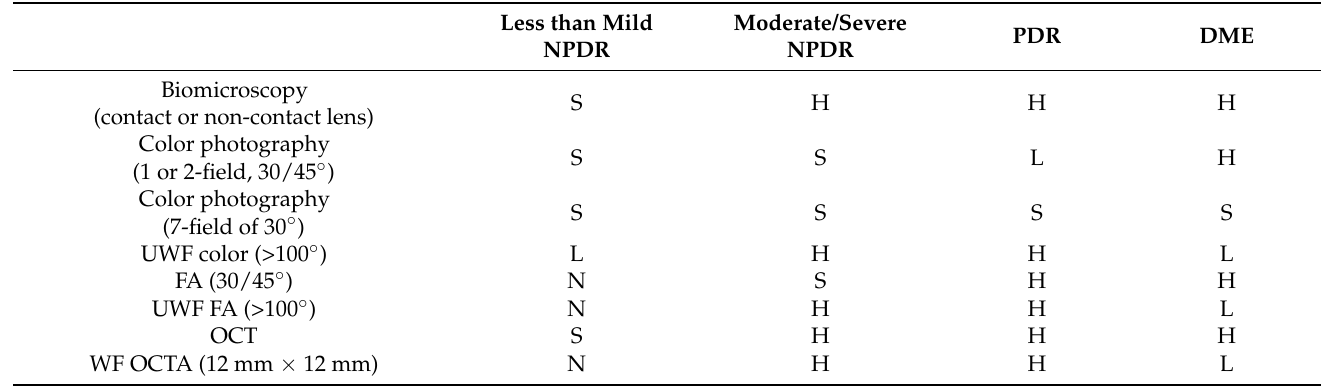
Table 2. Clinical applications of imaging methods to any stages of diabetic